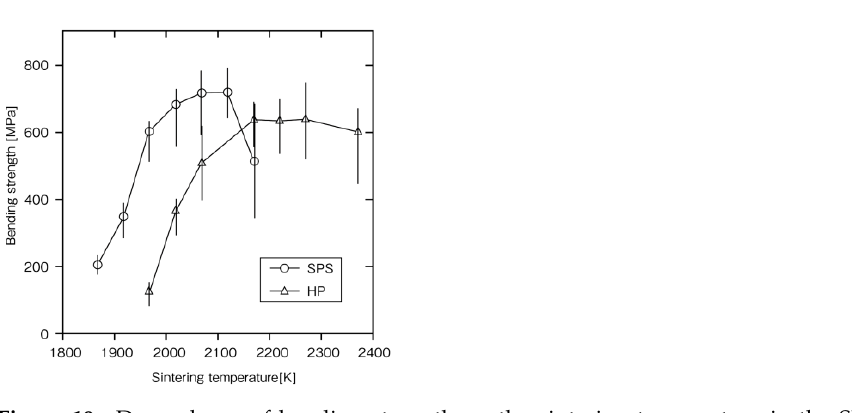
Figure 20. Dependence of Vickers hardness on the sintering temperature in the SPS- and HP-con- solidated SiCs. Figure 21. Dependence of relative density on applied pressure in the SPS-and HP-consolidated SiCs.